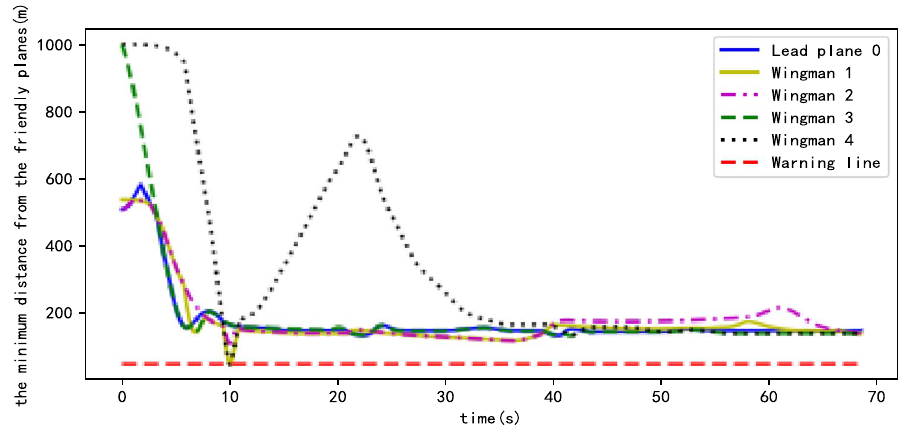
Figure 12. Minimum distance between formation members and friendly aircraft in the scene with obstacles.